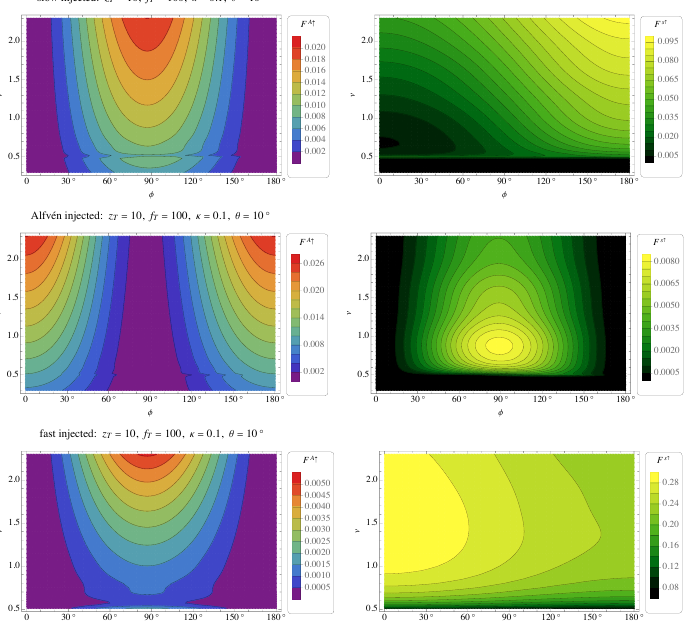
Figure 5. Alfvén ( left column ) and slow ( right column ) fluxes reaching z = + ∞ for injected slow ( top row ), Alfvén ( middle row ) and fast ( bottom row ) waves from z = − ∞ as functions of orientation φ and dimensionless frequency ν in the case κ = 0.1, θ = 10 ◦ , transition region height z T = 10 (in units of the chromospheric scale height H ), and TR temperature jump factor f T = 100.